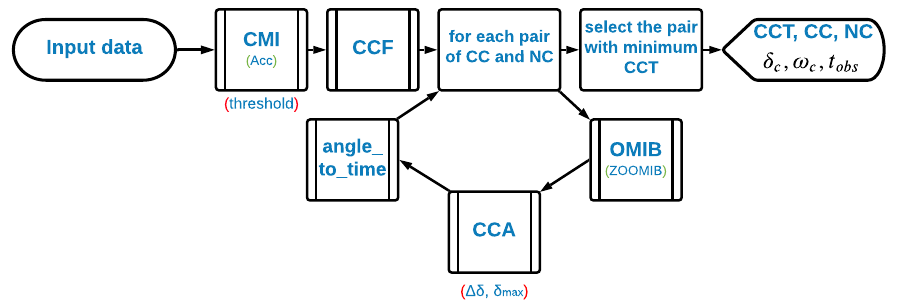
Figure 16. The basic scheme to estimate the CCT with EEAC.